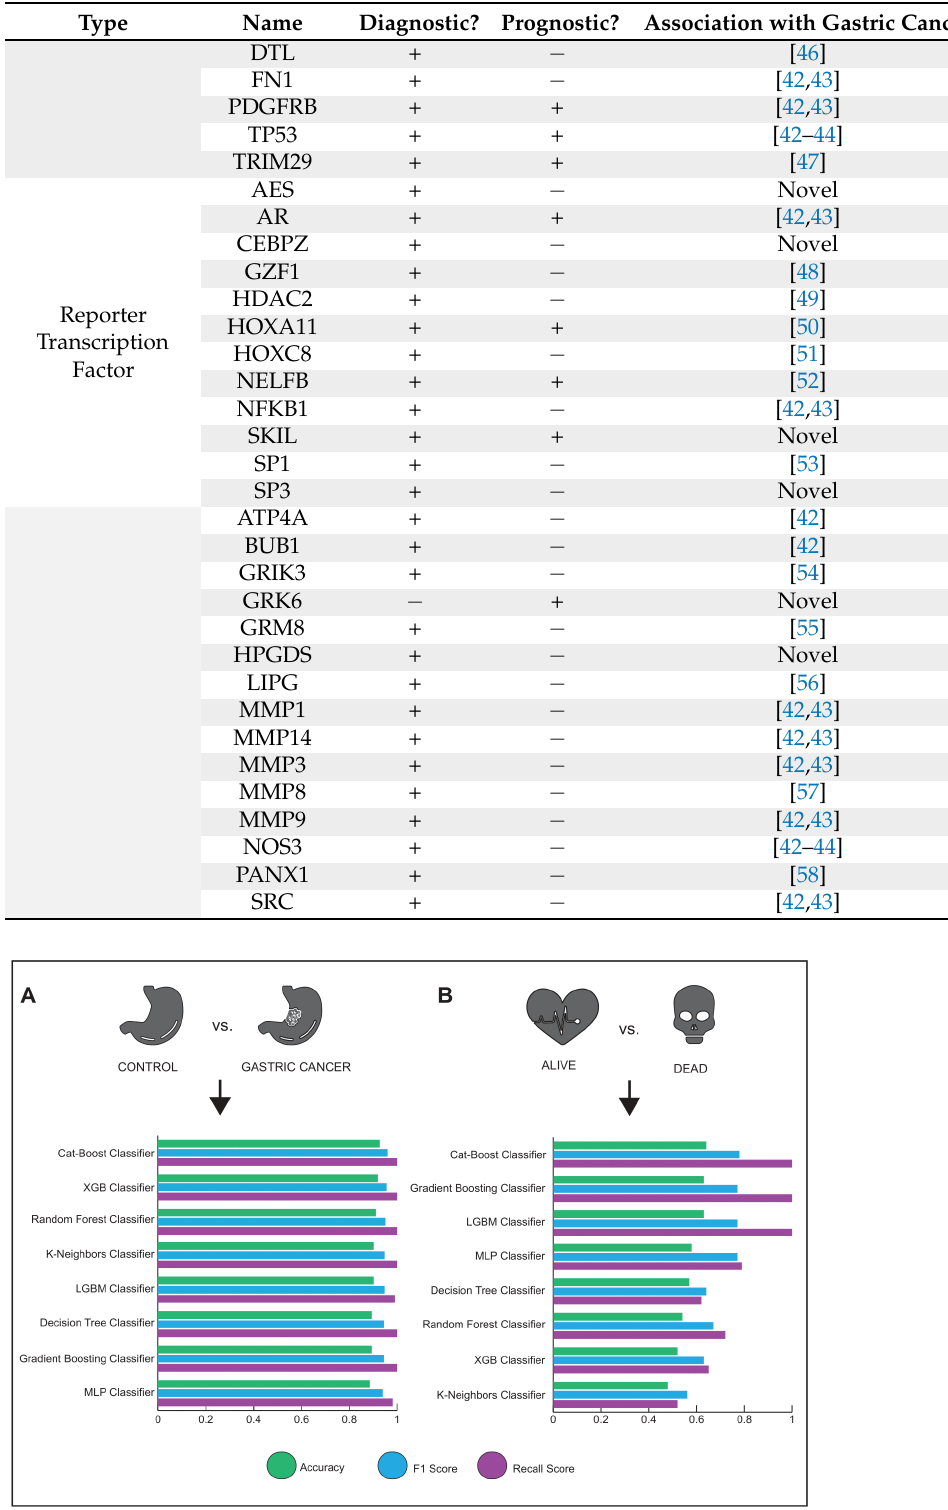
Figure 6. Machine learning analysis for novel diagnostic and/or prognostic biomarker candidates. ( A ) The accuracy, F1, and recall score plot of eight different classification algorithms for discriminating between diseased samples and controls. ( B ) The accuracy, F1, and recall score plot of eight different classification algorithms for discriminating between alive and dead samples.